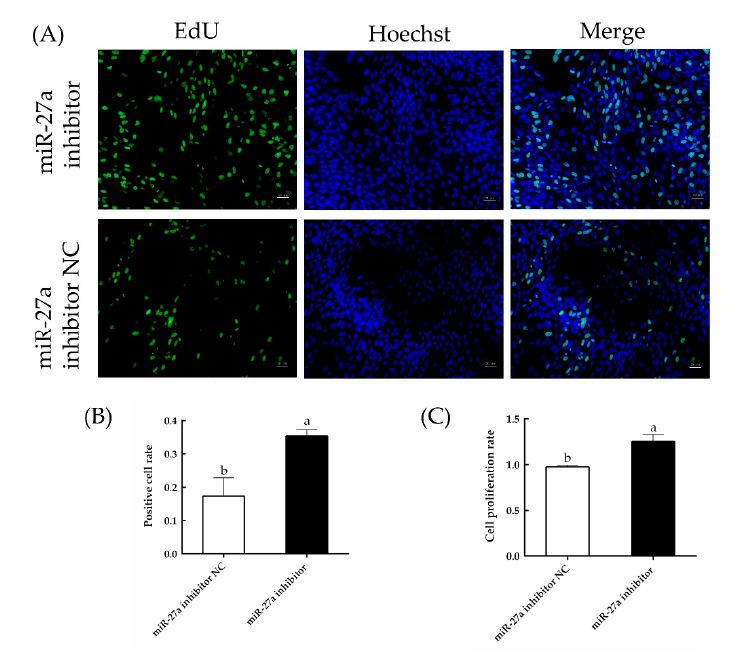
Figure 12. Effects of miR-27a inhibition on the proliferation of HFSCs. ( A ) HFSC proliferation was measured by EdU assays 24 h after transfection. ( B ) The rate of EdU-positive staining was quantified and is expressed as the number of EdU-positive cells divided by the total number of cells. ( C ) The proliferation of HFSC cells transfected with an miR-27a inhibitor or control was measured with CCK-8 assays. The different small letters (a, b) in the same graph indicate that the difference between groups is statistically significant ( p < 0.05).